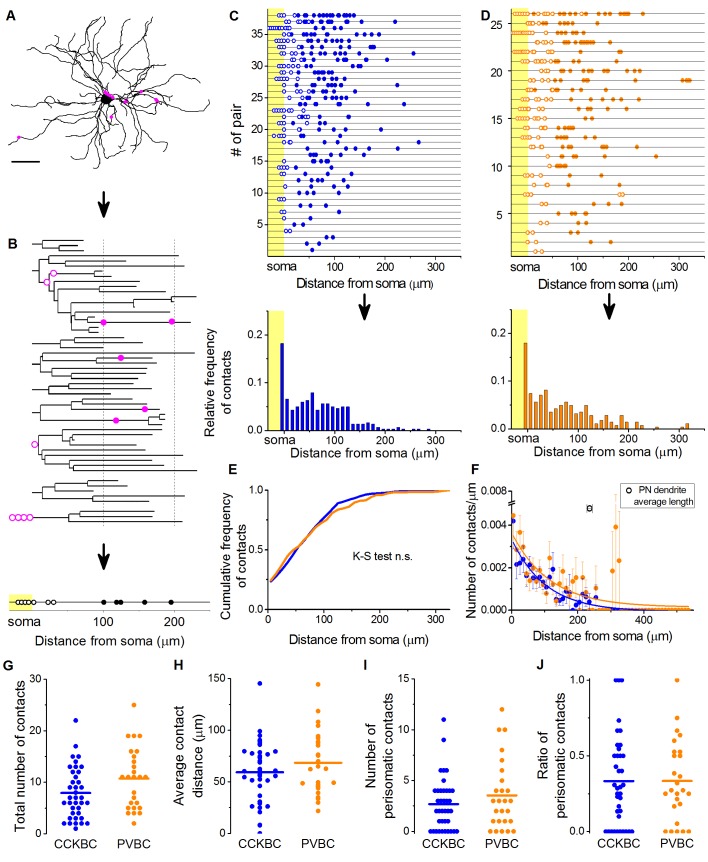
CCKBCs and PVBCs similarly innervate the soma-dendritic membrane surface of PNs.(A and B) Neurolucida reconstruction of the postsynaptic PN (same as in Figure 3) and its dendrogram analysis showing the contact sites on the perisomatic region (open magenta dots) and on the dendritic branches (filled magenta dots). Bottom on B: schematic visualization of the innervation pattern compressed along a single horizontal line. Somatic boutons shown in the yellow area, contacts on the perisomatic region are labeled with open dots and dendritic boutons with filled dots along the line indicating their distance from the soma. (C and D) Schematic innervation pattern of the reconstructed 38 CCKBC-PN and 26 PVBC-PN pairs. Bottom: Spatial distribution of the contacts, data from all pairs pooled together. (E) Comparison of the cumulative distribution of the contacts on PNs from the two BC types show no difference in the innervation patterns (p=0.29, K-S test). (F) BCs innervate the whole length of PN dendrites, however, the density of the contacts decreases exponentially towards the end of the dendrites (CCKBCs: r = 0.884, tau: 71.4 ± 8.2 µm; PVBCs: r = 0.557, tau: 79.7 ± 23.4 µm). Boutons contacting the cell bodies were excluded from this analysis. (G–J) Comparison of the total number of boutons (CCKBC: 7.92 ± 0.80, PVBC: 10.73 ± 1.16, p=0.065), the average bouton distance (CCKBC: 59.20 ± 4.80 µm, PVBC: 68.39 ± 5.97, p=0.38), the number of perisomatic boutons (CCKBC: 2.68 ± 0.41, PVBC: 3.53 ± 0.67, p=0.44) and ratio of perisomatic boutons (CCKBC: 0.33 ± 0.04, PVBC: 0.33 ± 0.05, p=0.83) of CCKBC-PN and PVBC-PN connections showed no significant difference (all M-W test, n = 38 CCKBC-PN pairs and n = 26 PVBC-PN pairs). Scale in A: 50 µm.